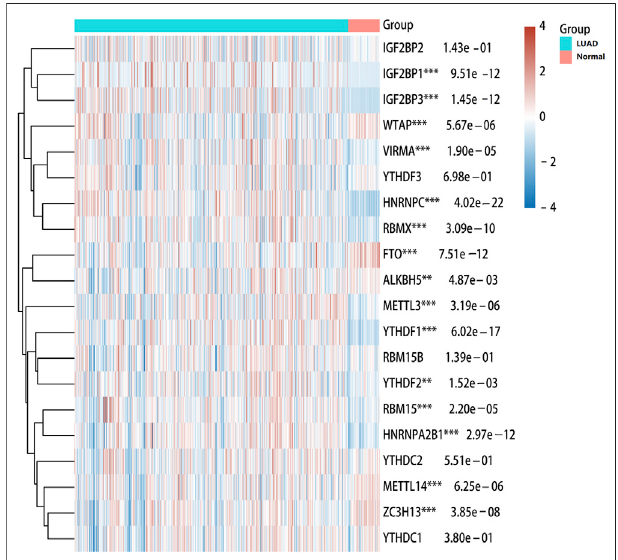
FIGURE 1 | Heatmap of expressions of m 6 A modi fi cation regulators between LUAD and normal samples. The different colors represent the expression trend in different samples. *** p < 0.001, ** p < 0.01, * p <